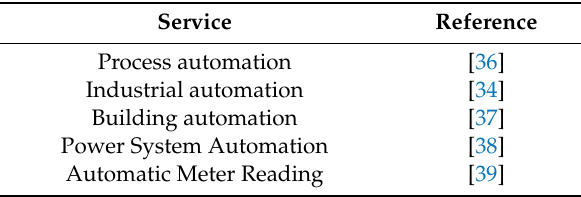
Table 5. Modbus use cases.